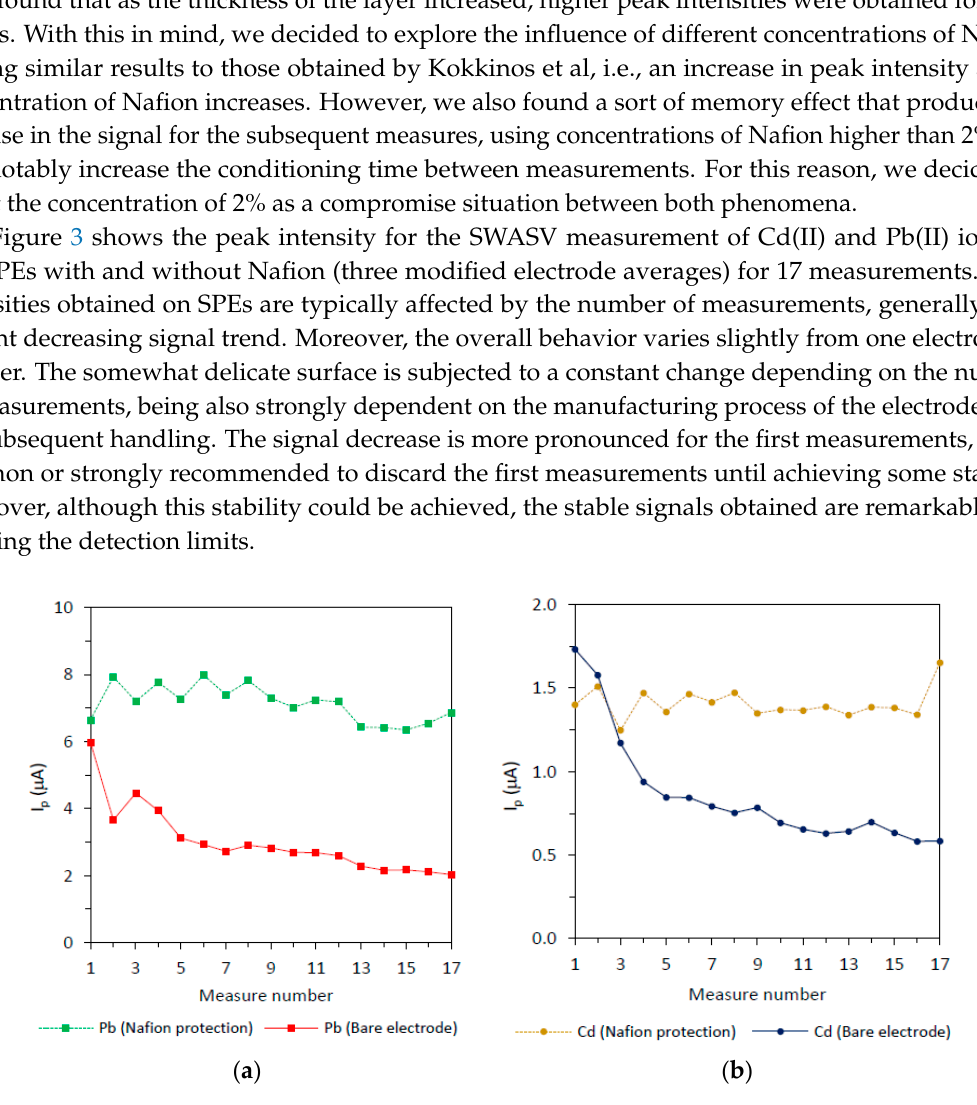
Figure 3. Peak current evolution for the different measure number of 30 ng/mL Cd(II) and 30 ng/mL Pb(II) at the Bi SP SPE with and without Nafion protection on the working electrode. Experimental